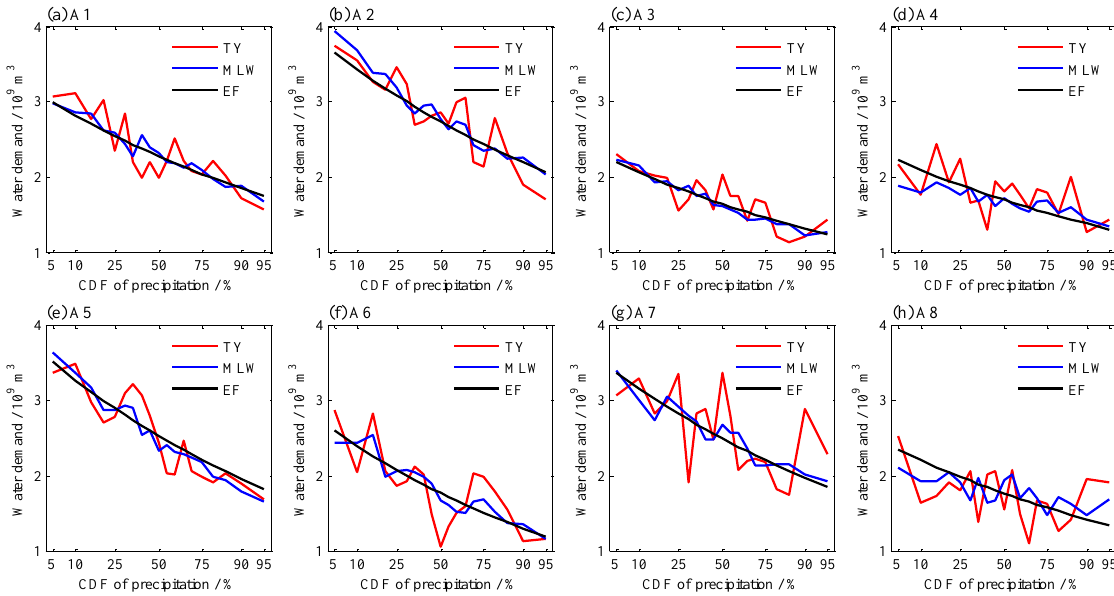
Figure 12. Design water demand of irrigation in sub-regions for given CDFs of precipitation of the entire